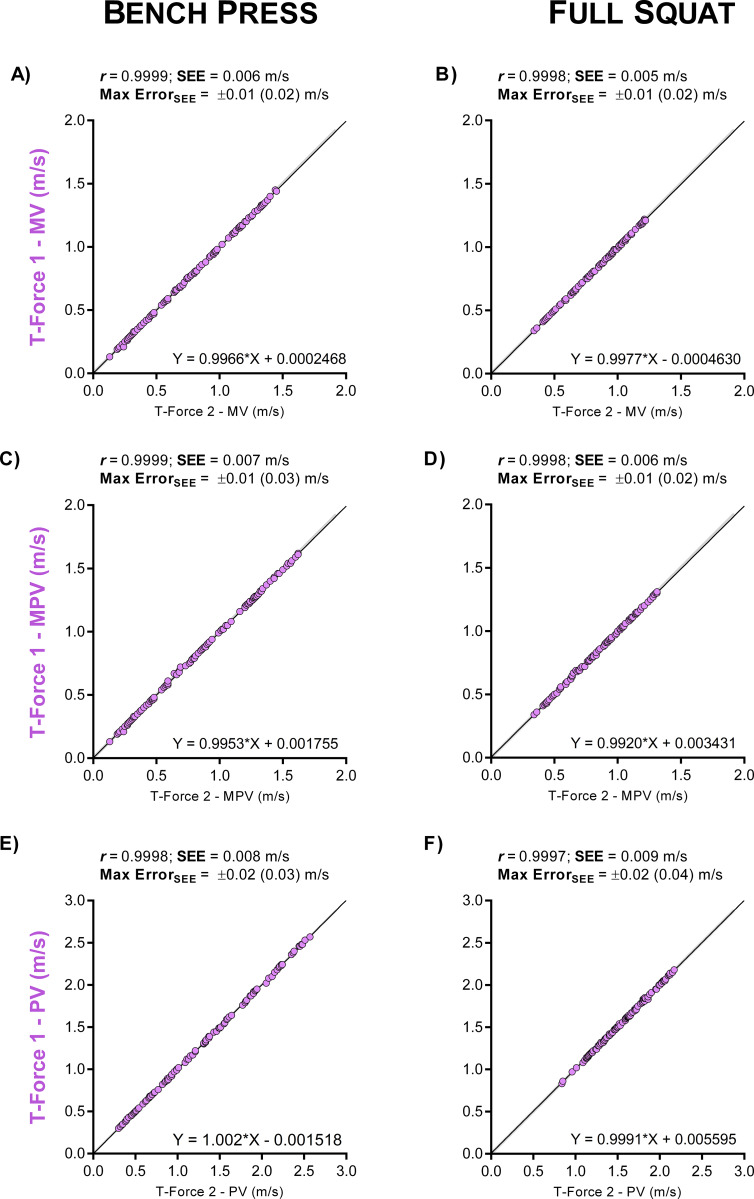
Intra-device agreement between two T-Force devices.Linear regressions for the velocity readings in bench press (A, C and E panels) and full squat (B, D and F panels) exercises. Panels are ordered by velocity outcomes: mean velocity (MV), mean propulsive velocity (MPV) and peak velocity (PV).